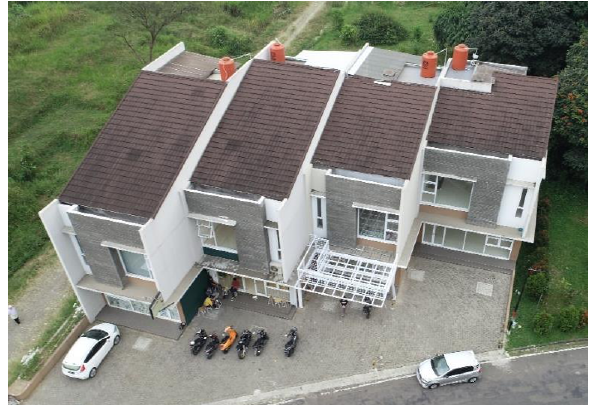
Figure 2. Sample drone photograph of the office Building